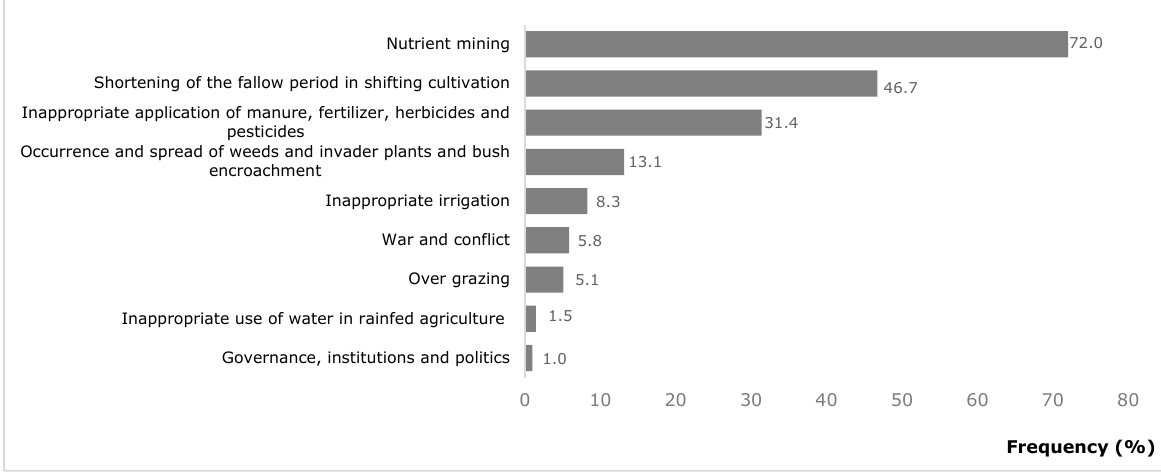
Figure 5. Perceptions of the causes of land degradation in the community in south-western Côte d’Ivoire.